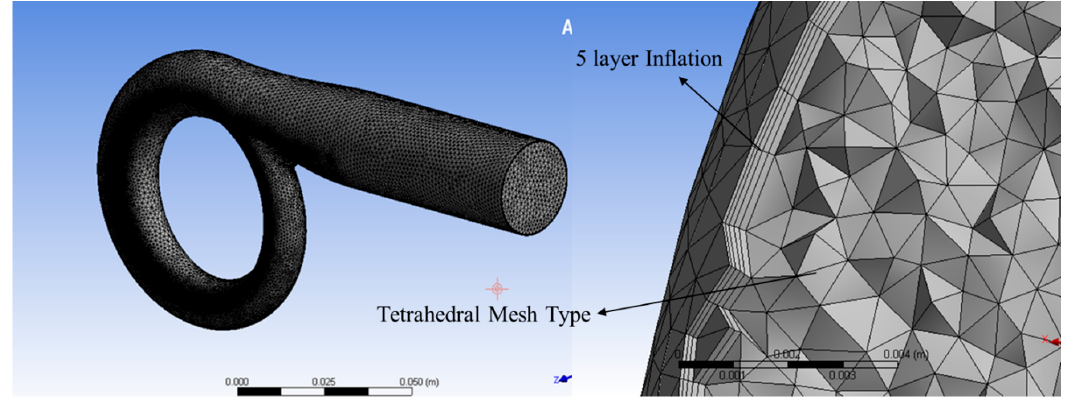
Figure 6. Discretization of the volute with a five-layer inflation.